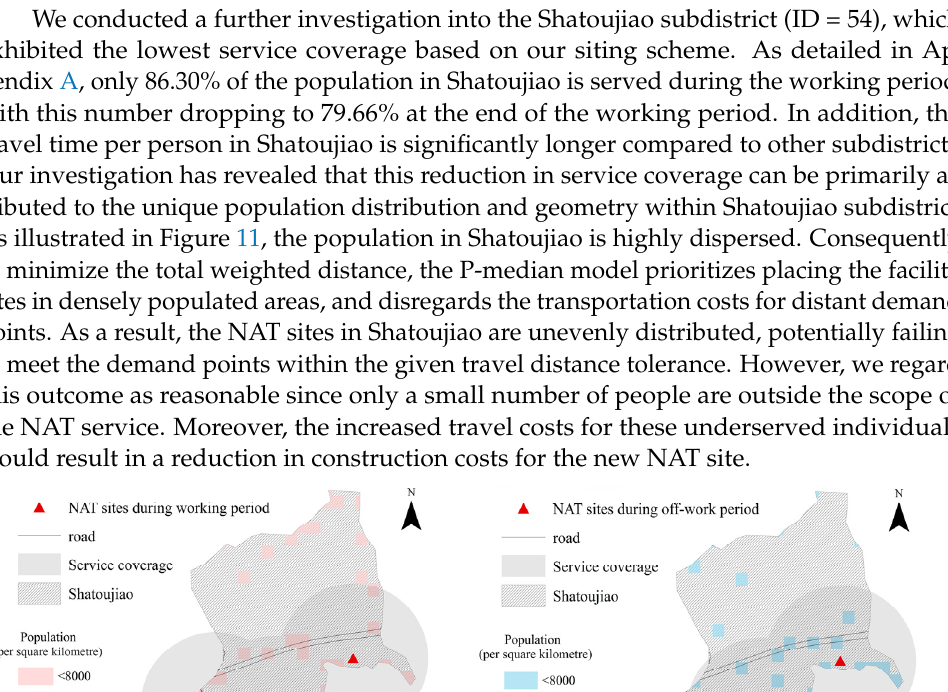
Figure 10. Distribution and population dynamics of Lianhua, Dalang, and Longgang subdistrict. The number within the subdistrict indicates the people’s average travel time to reach the nearest NAT site based on our scheme.